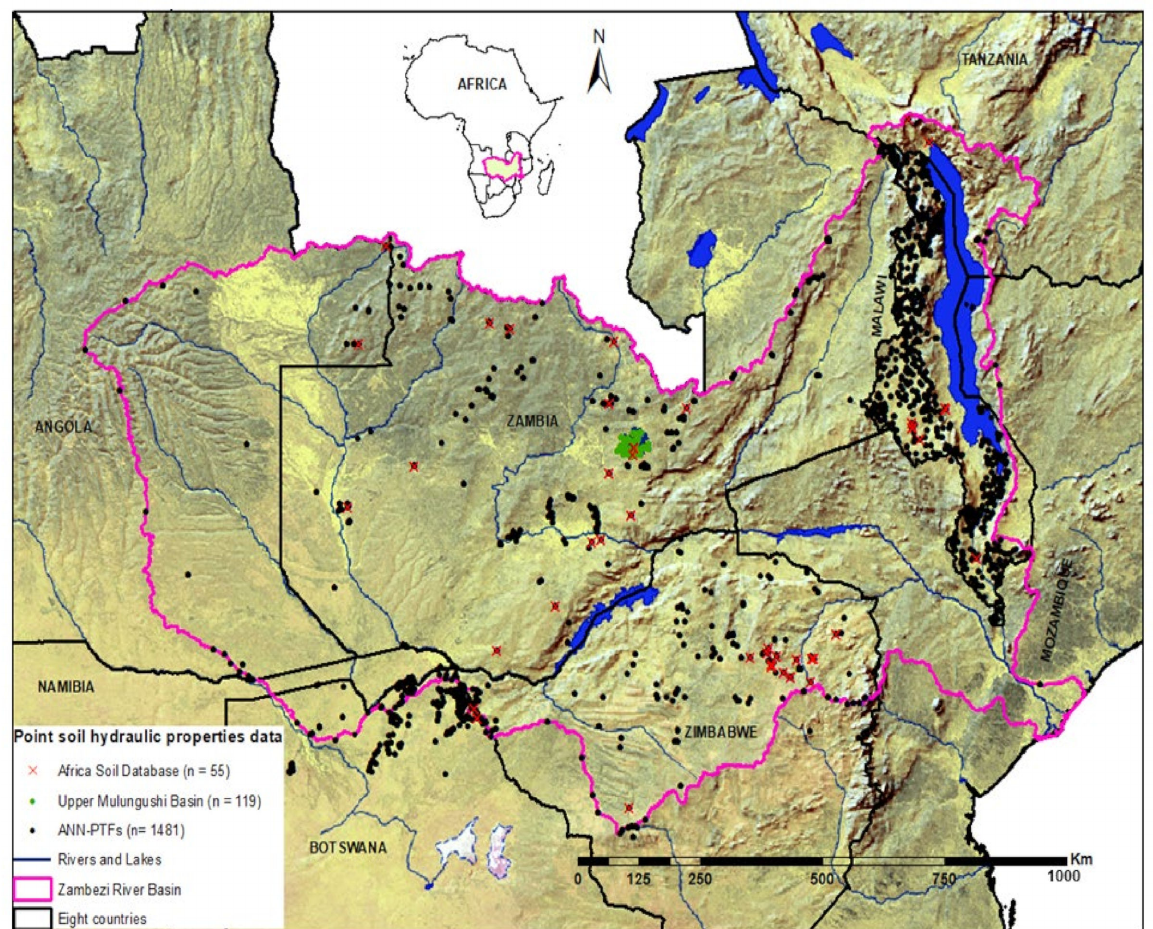
Figure 2. The Zambezi River Basin and location of (i) the soil profiles in the African Soil Profile database ( n = 55 in red), for which soil hydraulic data are available, (ii) own soil sampling points in the Upper-Mulungushi subbasin in central Zambia ( n = 119 in green), and (iii) of the soil profiles in the African Soil Profile database ( n = 1481 in black), for which soil hydraulic data were estimated using ANN-PTFs